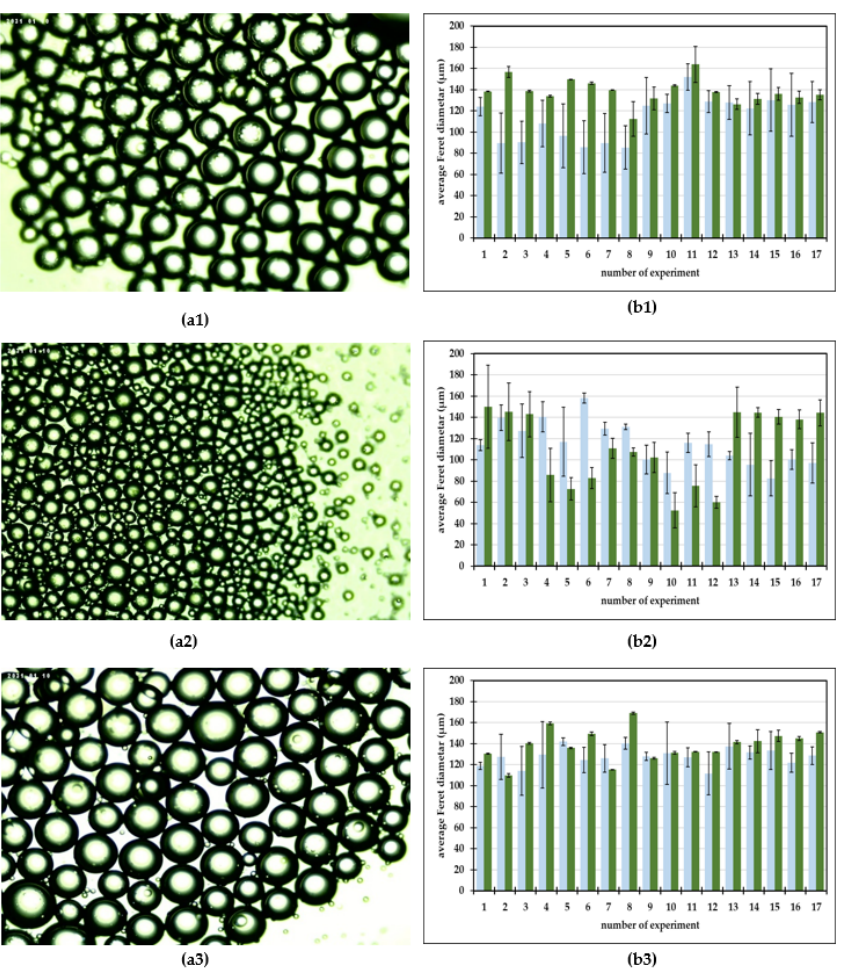
Figure 2. ( a ) Photos of oil-in-aqueous mint extract emulsions. ( b ) Average Feret diameters of oil-in- water emulsions ( ) and oil-in-aqueous mint extract emulsions ( ). ( a1 , b1 ) PEG 1500, ( a2 , b2 ) PEG